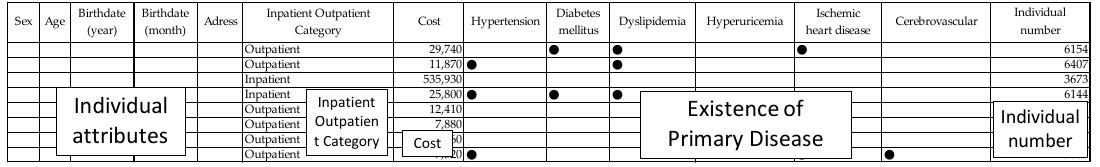
Figure 2. Example of MHLW form (Form 1-1) (source: created from the KDB data of Hakui City).